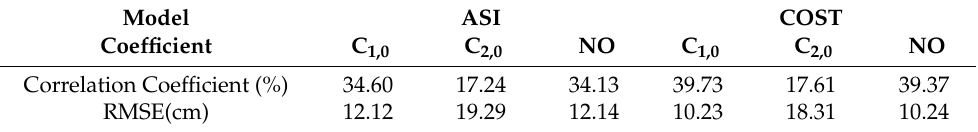
Table 10. The average results of Swarm-TWSC of different coefficients compared with GRACE-TWSC in 26 basins.